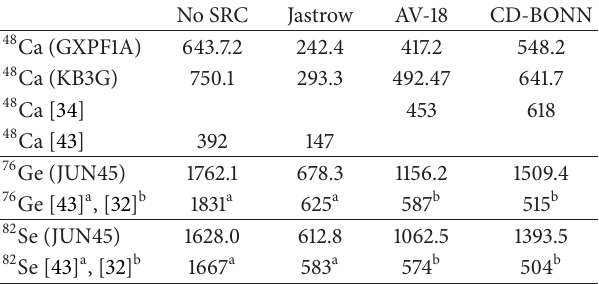
Table 2: 0 ] 𝛽𝛽 NMEs values for SUSY1 mechanism and comparison to other results in the literature.